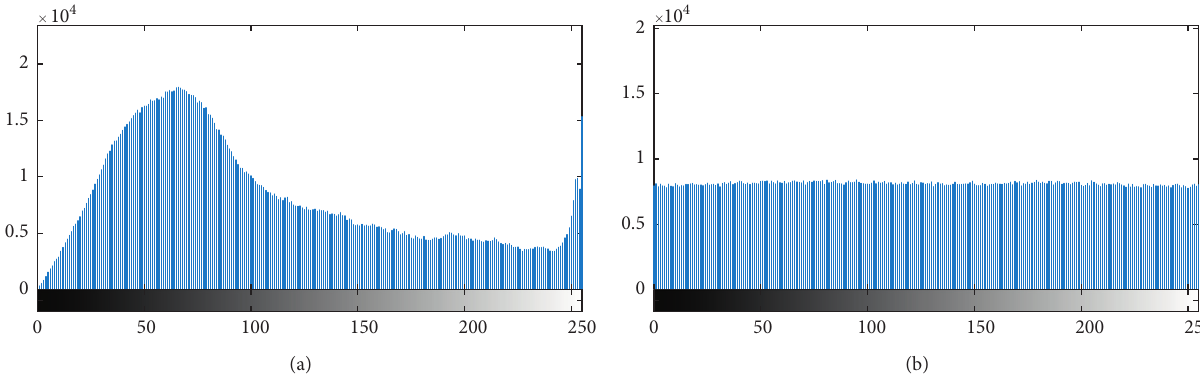
Figure 7: Histogram between the original and encrypted pictures. (a) Histogram of the original picture. (b) Histogram of the encrypted